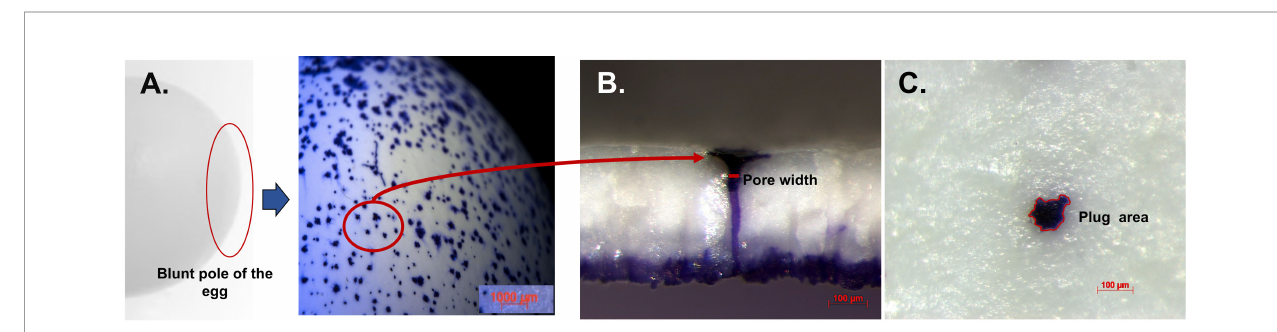
FIGURE 8 | Crystal violet stained cuticle protein in pores and plug visualized by stereomicroscopy. (A) Outer surface of white ungraded chicken eggshell (21 wk) showing pore surfaces at 10X. (B) Cross-fractured eggshell showing plug and pore lined by stained protein at 150X magni fi cation. (C) Outer surface of eggshell showing magni fi ed pore plug at 150X. Reprinted from Poultry Science, Vol. 97, Issue 4, Kulshreshtha et al., Cuticle and pore plug properties in the table egg, 1382- 1390, 2018, with permission from